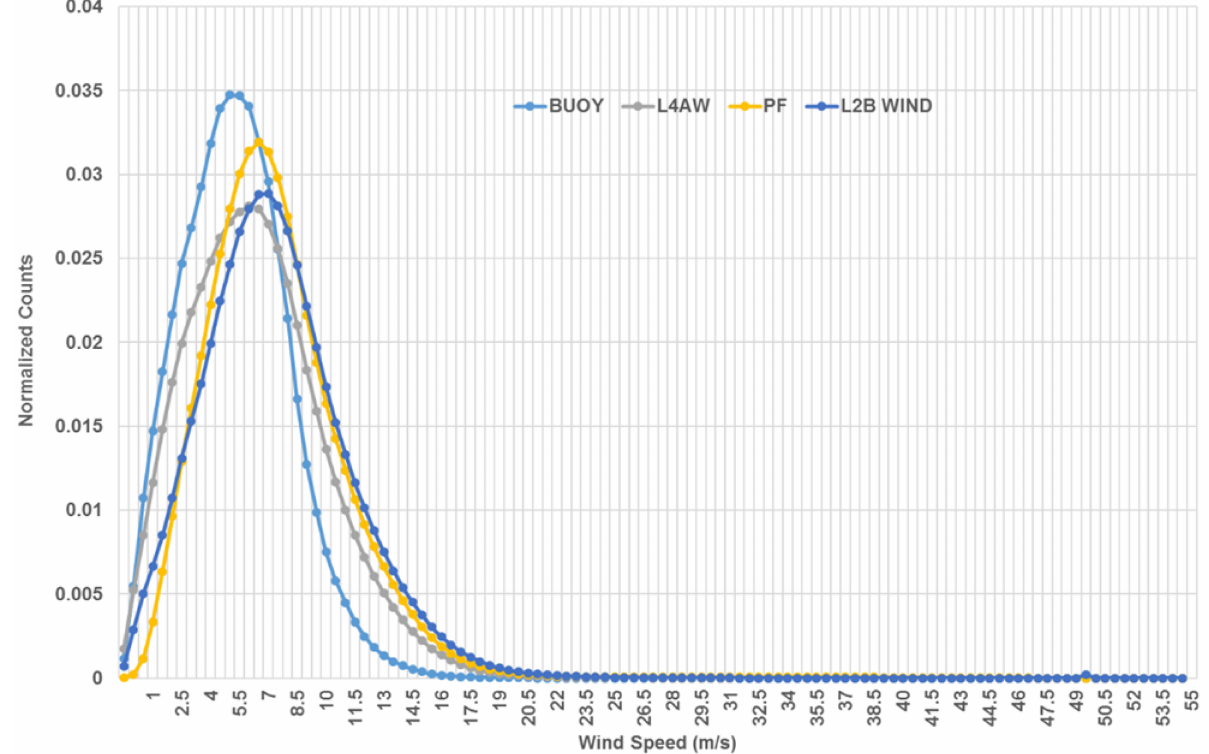
Figure 11. The normalized histogram of SCATSAT-1 L2B, daily L4AW wind speed, particle filter- based reanalyzed wind speed and wind speed observations from NDBC global